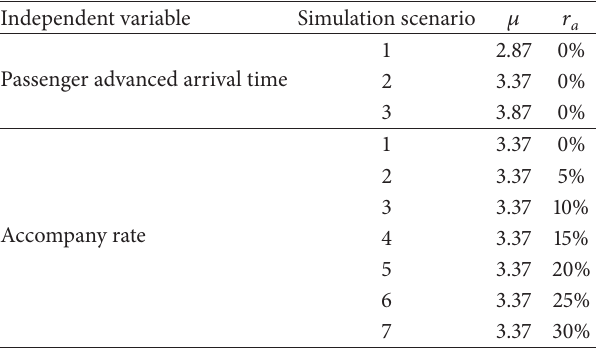
Table 6: The simulation scenarios of the basic experiment. Figure 7: The number of aggregation passengers varies over the values of the passenger advanced arrival time.